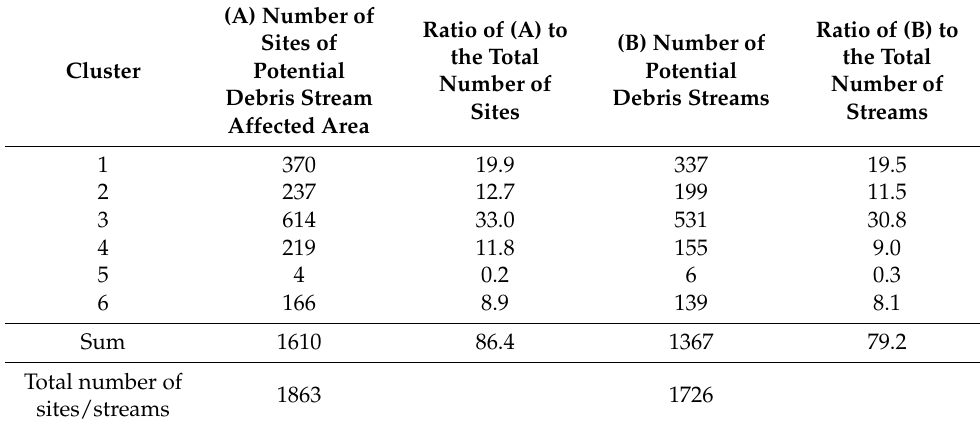
Table 4. The number of potential debris streams and affected areas in each